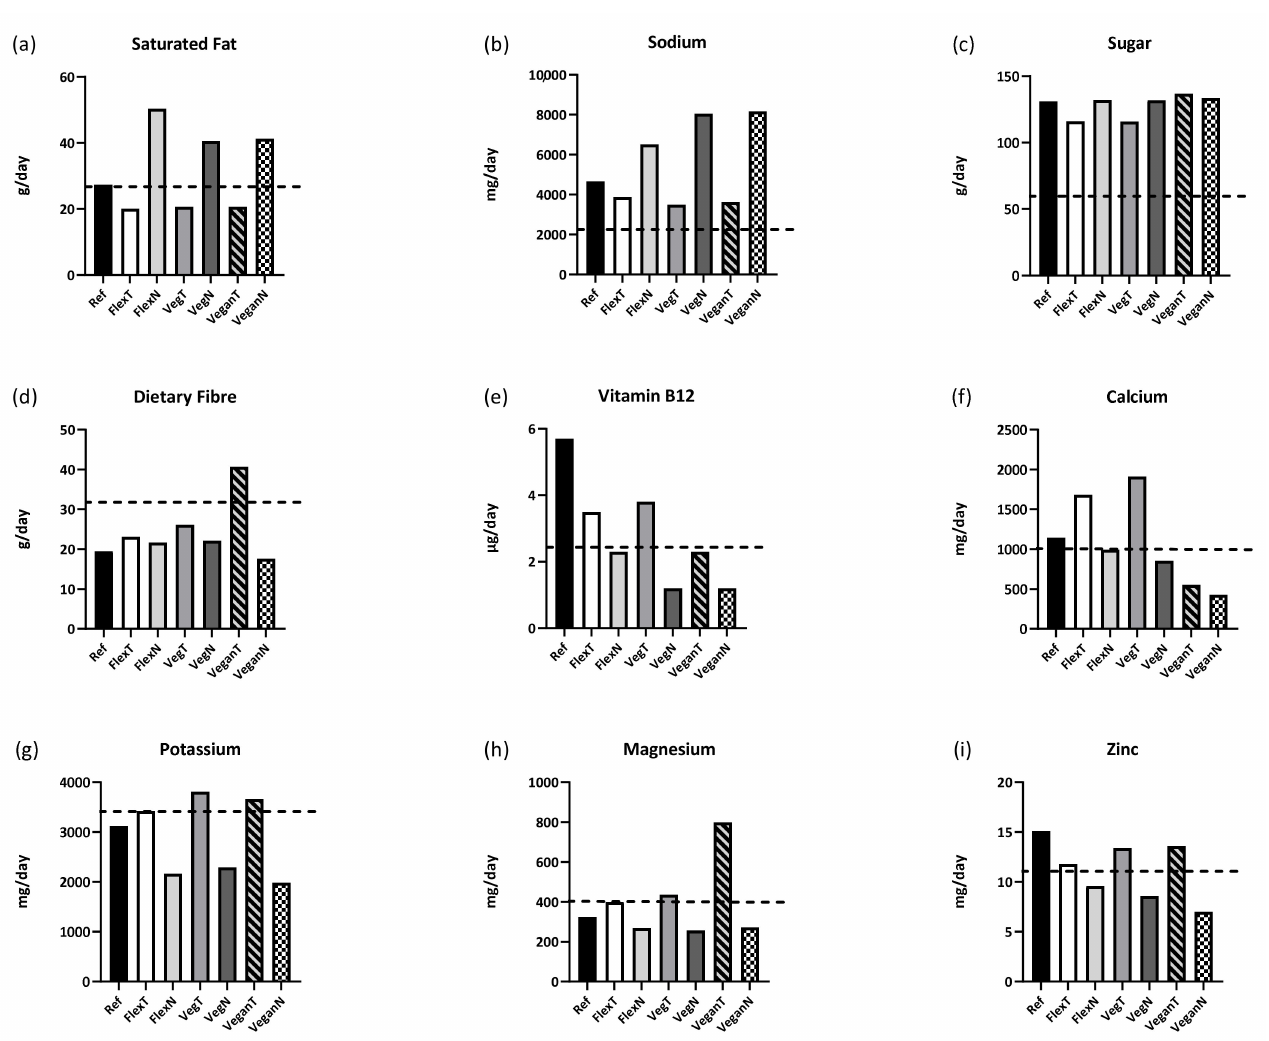
Figure 1. Comparison of nutrient intakes across omnivore, flexitarian (traditional and novel), vegetarian (traditional and novel) and vegan (traditional and novel) diets for ( a ) saturated fat, ( b ) sodium, ( c ) sugar, ( d ) dietary fibre, ( e ) Vitamin B12, ( f ) calcium, ( g ) potassium, ( h ) magnesium and ( i ) zinc. The dotted line in each graph denotes the daily nutritional goal for that nutrient [22]. Ref = reference diet, FlexT = flexitarian-traditional diet, FlexN= flexitarian-novel diet, VegT = vegetarian- traditional diet, VegN = vegetarian-novel diet, VeganT = vegan-traditional diet, VeganN = vegan-novel